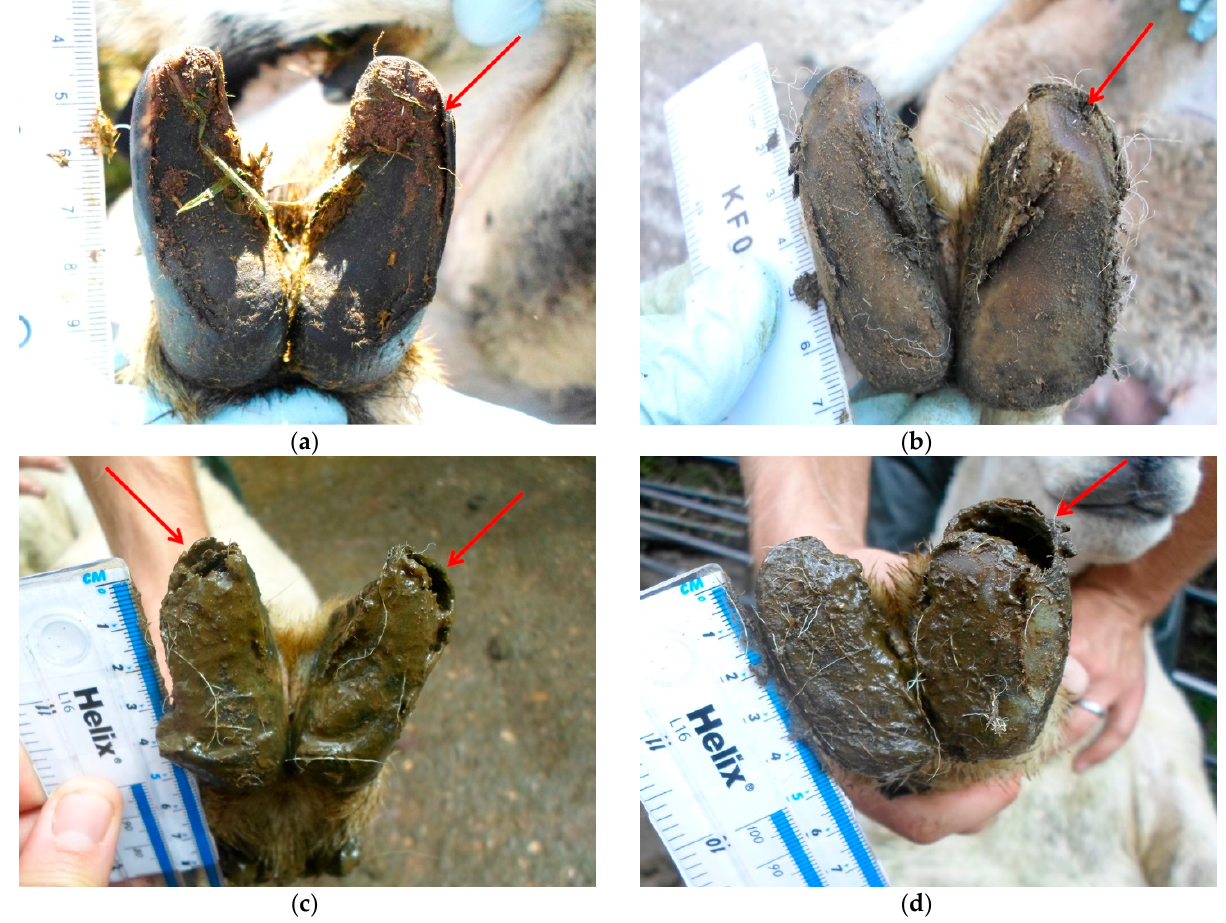
Figure 1. ( a ) Discrete separation of the abaxial hoof wall at the white line (red arrow); ( b ) Discrete discolouration and separation of the abaxial hoof wall at the white line (red arrow); ( c ) Extensive separation at the toe and along the abaxial hoof wall on both paired claws (red arrows); ( d ) Major cavity ‘pocket’ with loss of hoof wall integrity (red arrow).